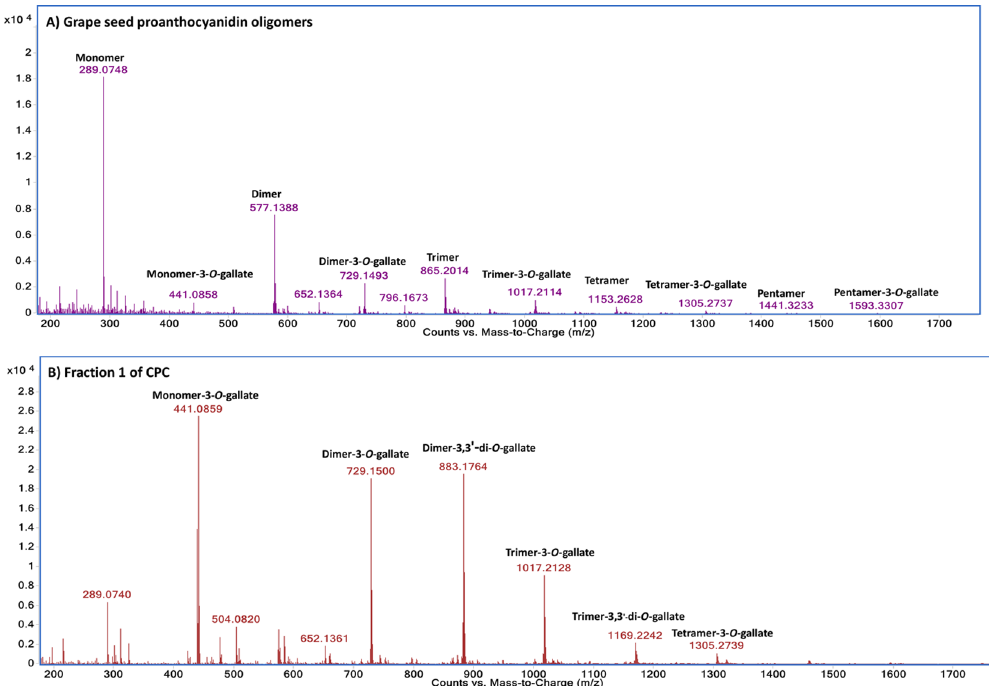
Fig 3. MS spectra obtained for crude extract (A) and fraction 1 of CPC